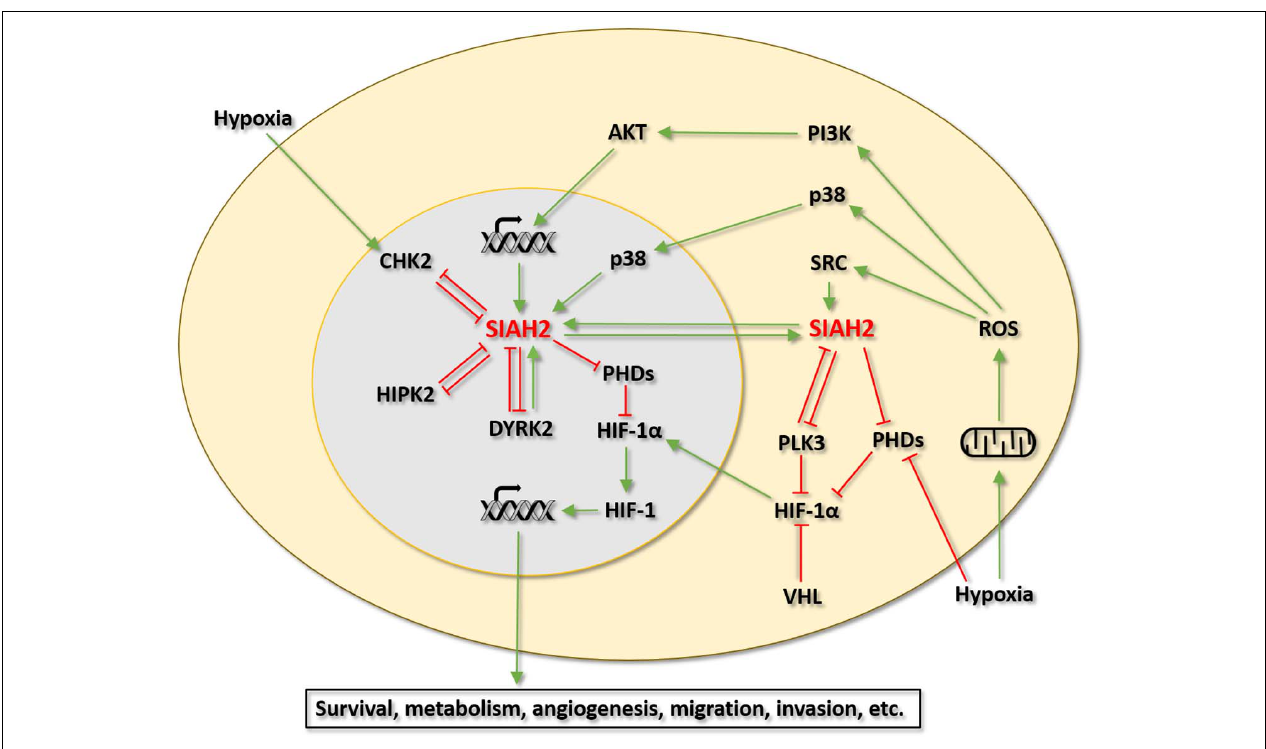
FIGURE 2 | Regulation of the SIAH2-HIF-1 axis by protein kinases. Green arrows indicate activation. Red T bars indicate